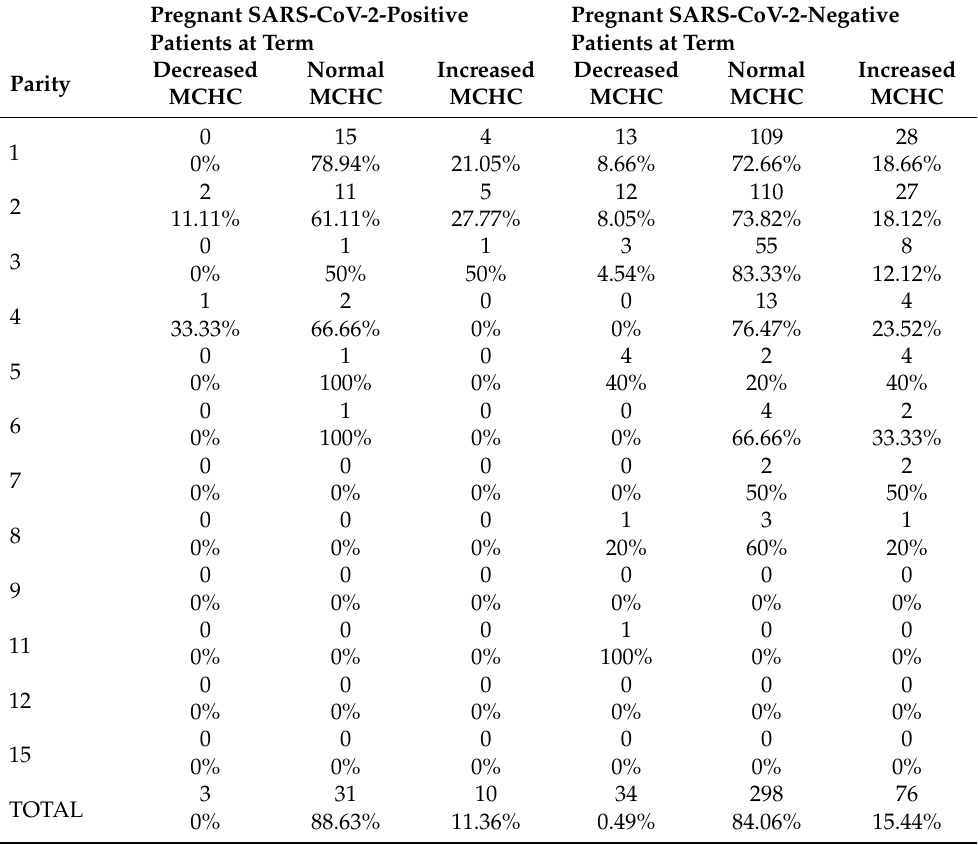
Table 14. Number and percentage of pregnant patients with normal, increased, and decreased values of MCHC, as regards